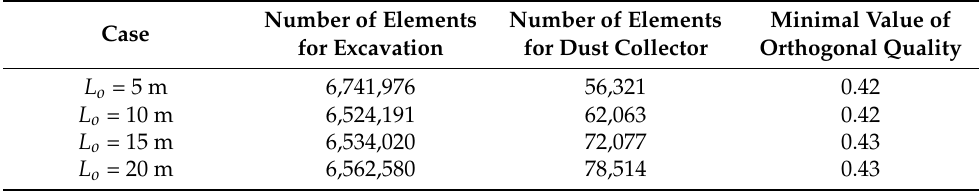
Table 4. Number of elements and minimal orthogonal quality for each